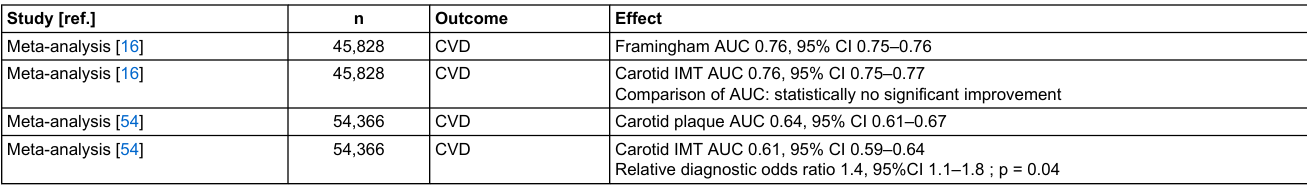
Table 2c: Meta-analyses on outcome studies comparing traditional risk factor models with carotid intima media thickness and carotid plaque. Study [ref.]